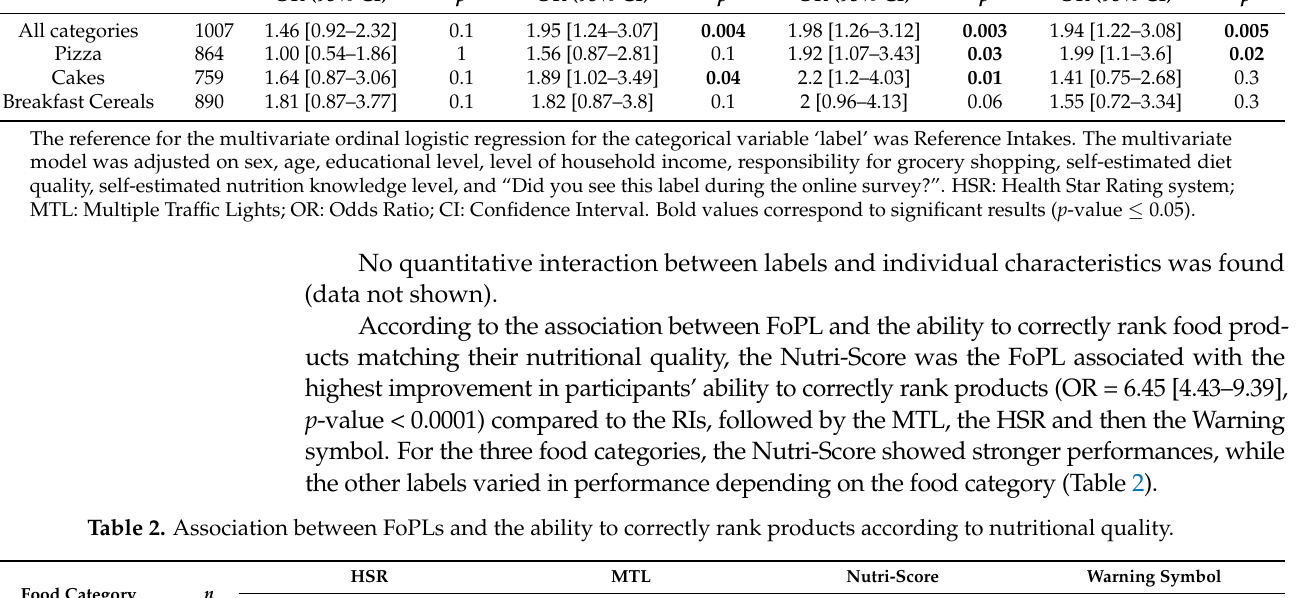
Table 1. Association between FoPLs and change in the nutritional quality of food choices. Food Category